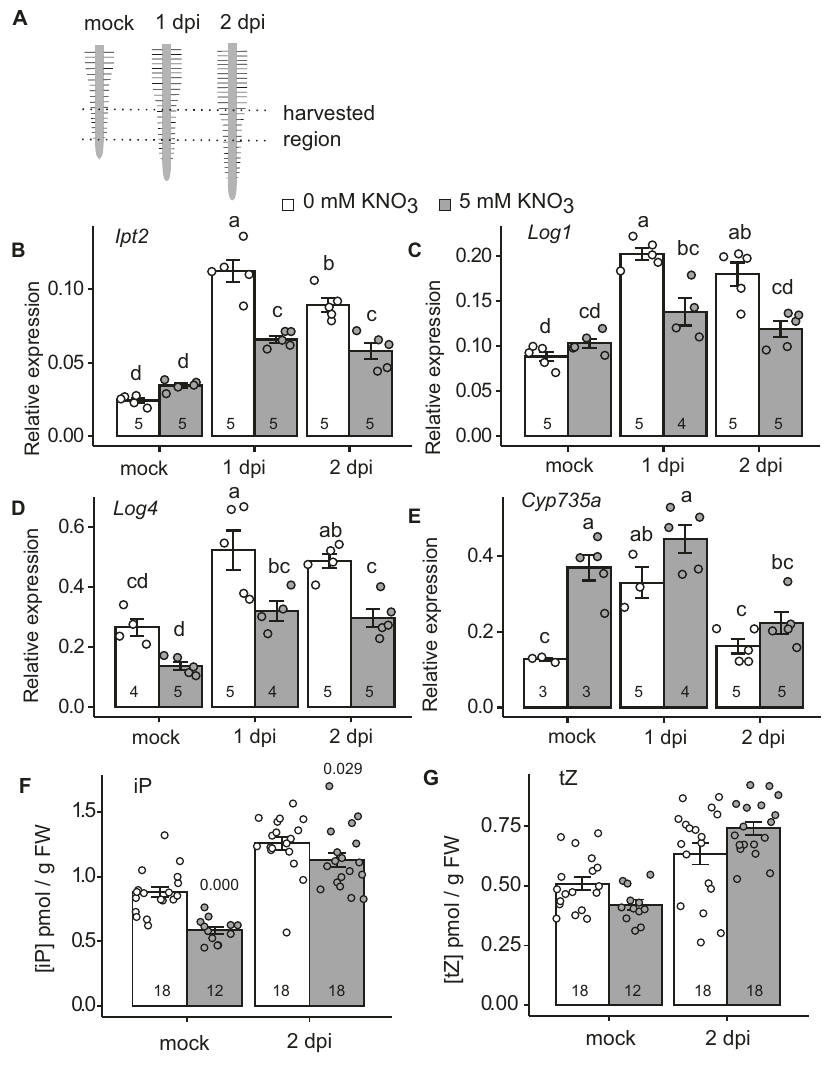
Fig. 1 Nitrate inhibits induction of symbiotic cytokinin biosynthesis. A The root zone which was susceptible to nodule initiation at time of inoculation was used for qRT-PCR and cytokinin analysis. B – E Relative transcript abundance of selected cytokinin biosynthesis genes by qRT-PCR 1 and 2 days post inoculation (dpi) with M. loti in the absence and presence of 5 mM KNO 3 . Ubiquitin is used as a reference gene. E , F Cytokinin-free base content (iP and t Z) analysed in mock or 2 days post inoculation with M. loti in the absence and presence of 5 mM KNO 3 . Bars show mean ± SE for the n value shown on each bar. Signi fi cant differences among different conditions are indicated by letters ( p < 0.05) as determined by ANOVA and Tukey post-hoc testing for B – E . Pairwise P -values as determined by Tukey testing are available in the Source Data fi le. Signi fi cant differences between nitrate presence and absence conditions as determined by Wilcoxon rank-sum test is indicated by the annotated P values in F , G